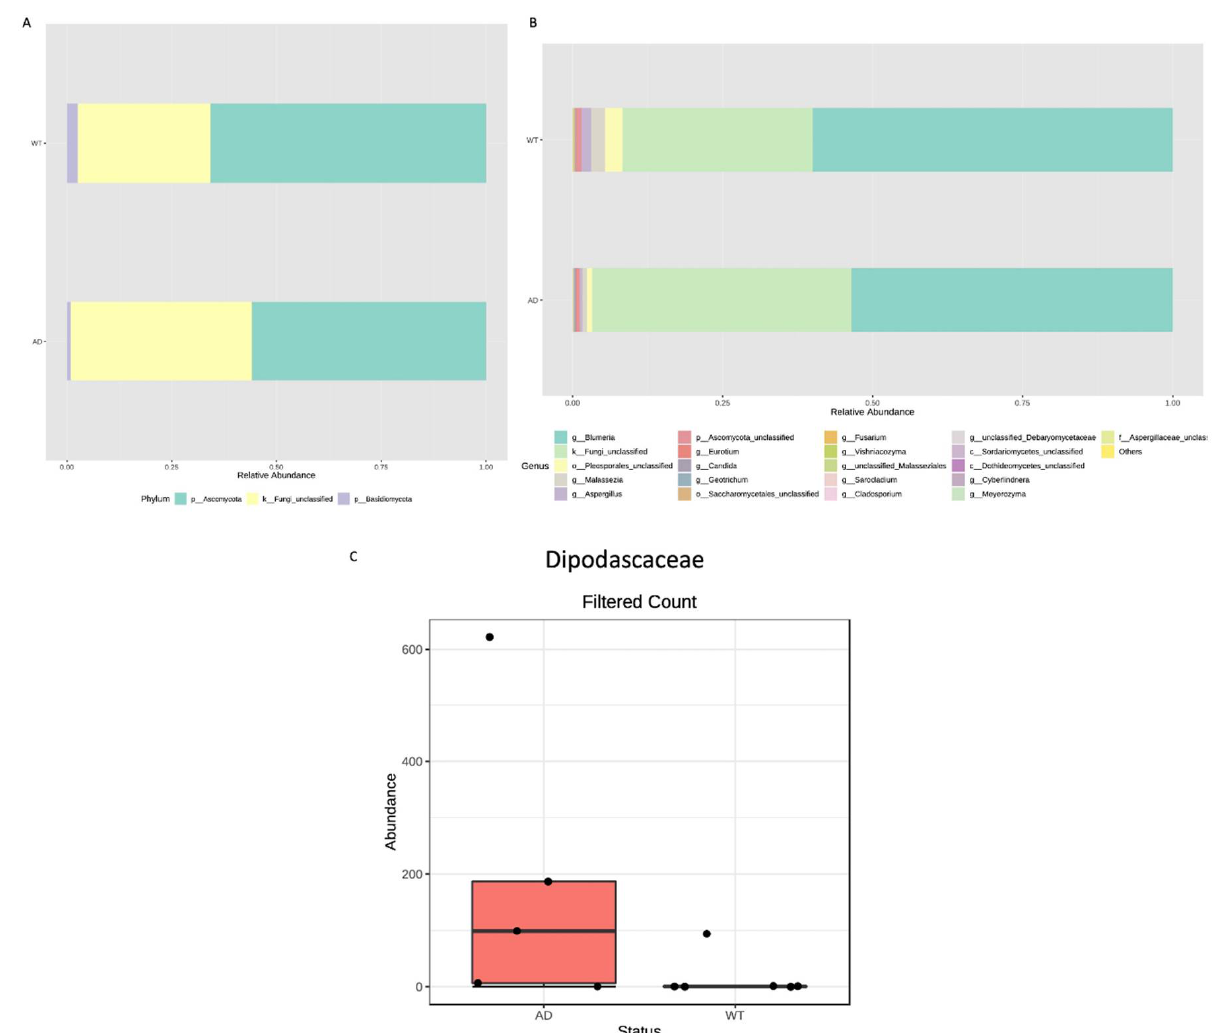
Figure 5. Fungal microbiota composition of AD and WT mice. Taxonomic assignment is shown at phylum ( A ) and genus ( B ) levels as relative abundance (%) of each identified taxon/group. Differential abundance analysis highlighted just one significantly different taxon, the Dipodascaceae family, which appears increased in the AD compared with the WT mice ( C ).